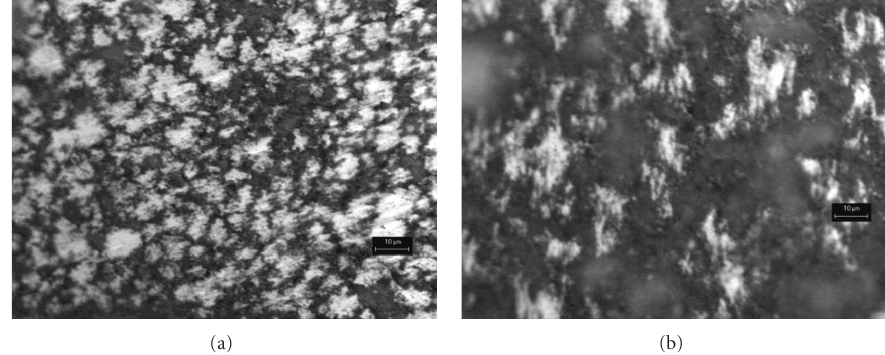
Figure 4: Micrographs of sintered 20wt.% (a) and 30wt.% (b) ceramic content nickel-alumina composites.